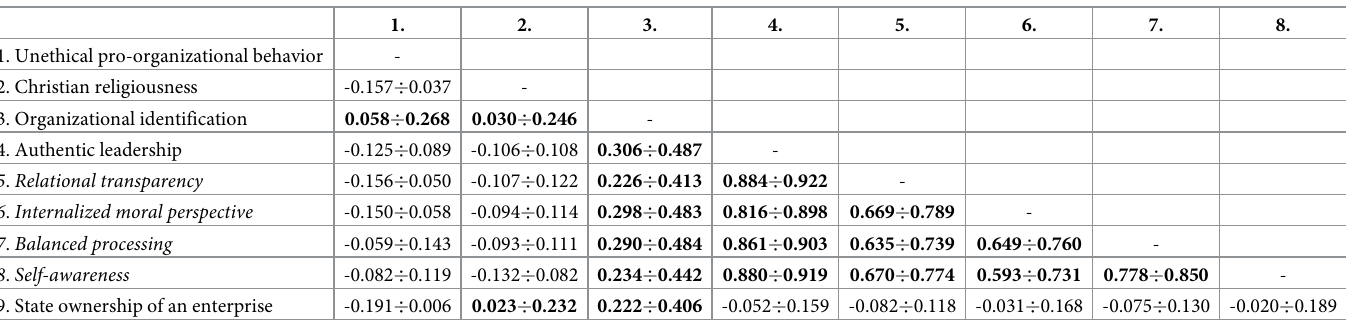
Table 7. The coefficients of correlation among the variables under analysis obtained via